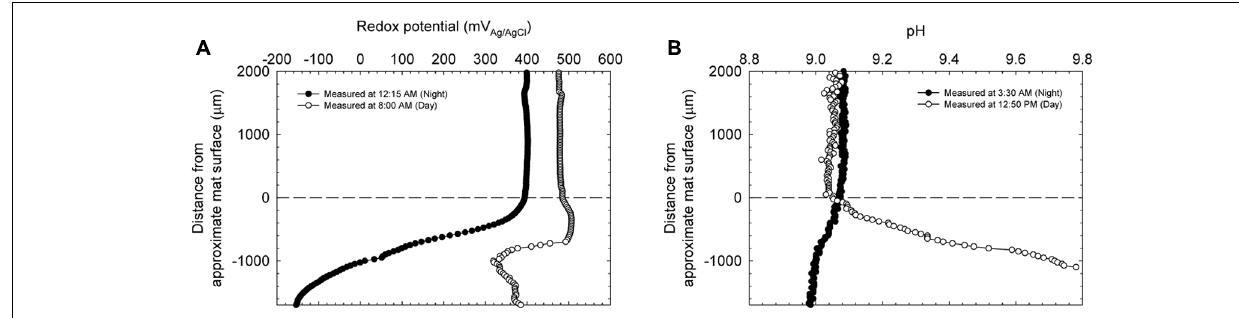
FIGURE 3 | Redox potential (A) and pH (B) depth profiles entering the upper strata of the explanted microbial mats at two time points during a diel cycle. Zero indicates the approximate location of the mat’s surface.